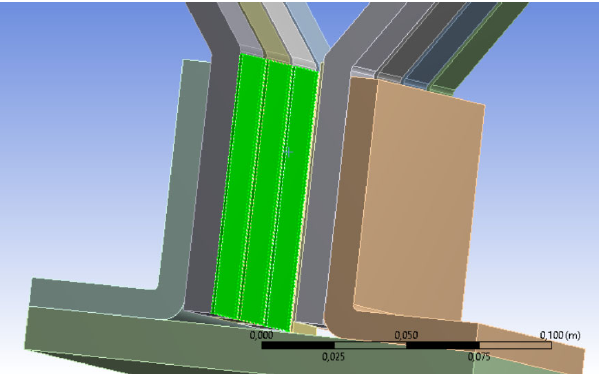
Figure 4. An illustrative representation of impurities on contacts (green).